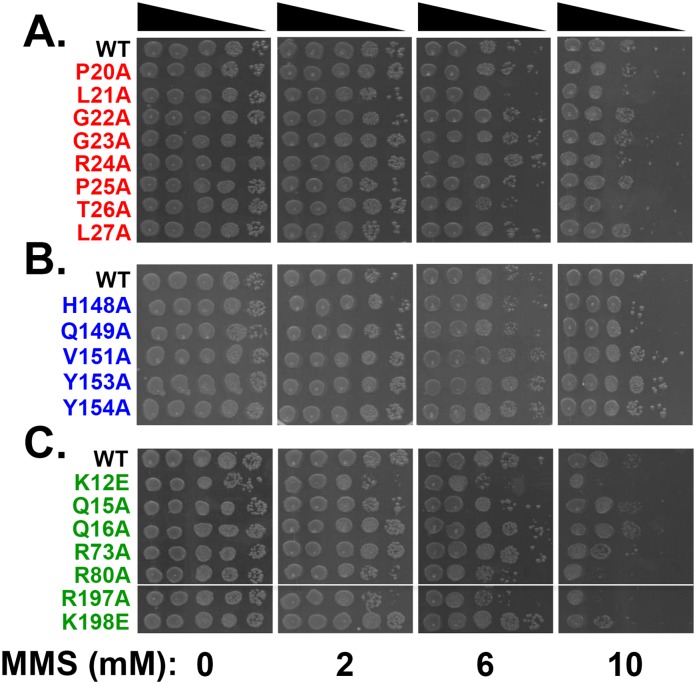
Sensitivity of mutant dnaN strains to MMS.MMS sensitivity of dnaN strains bearing mutations in (A) loop I (red), (B) loop II (blue) or (C) the central pore of the β clamp (green) was measured as described in Materials and Methods. This experiment was performed 4 times with 2 separate clones. Representative results shown.